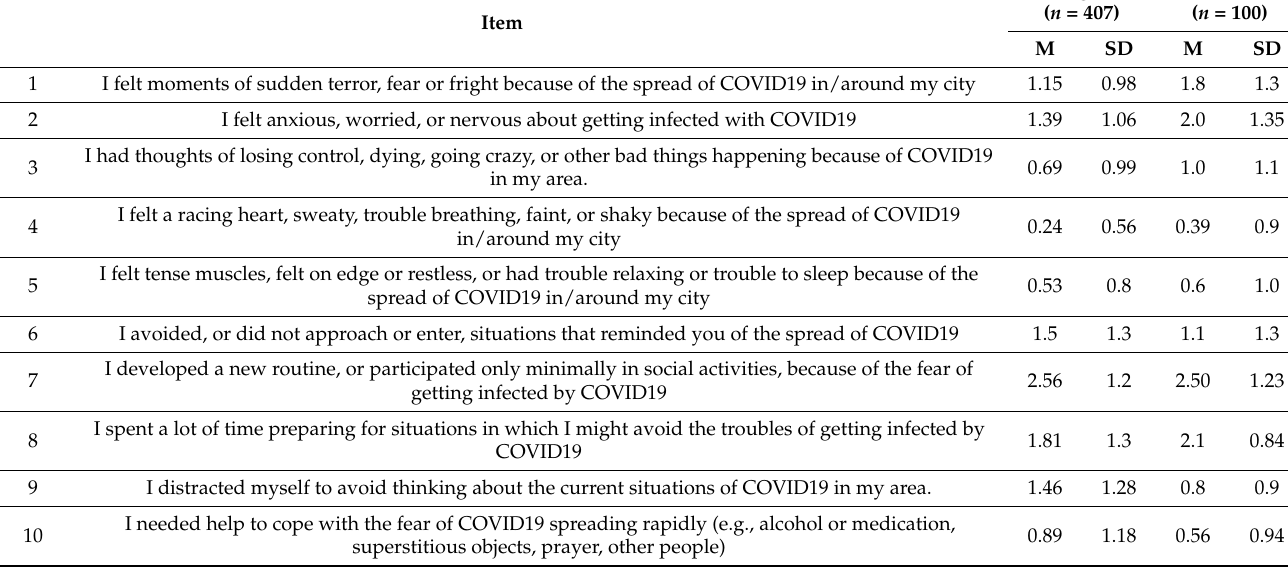
Table 2. Descriptive analysis/panic disorder mean scores.